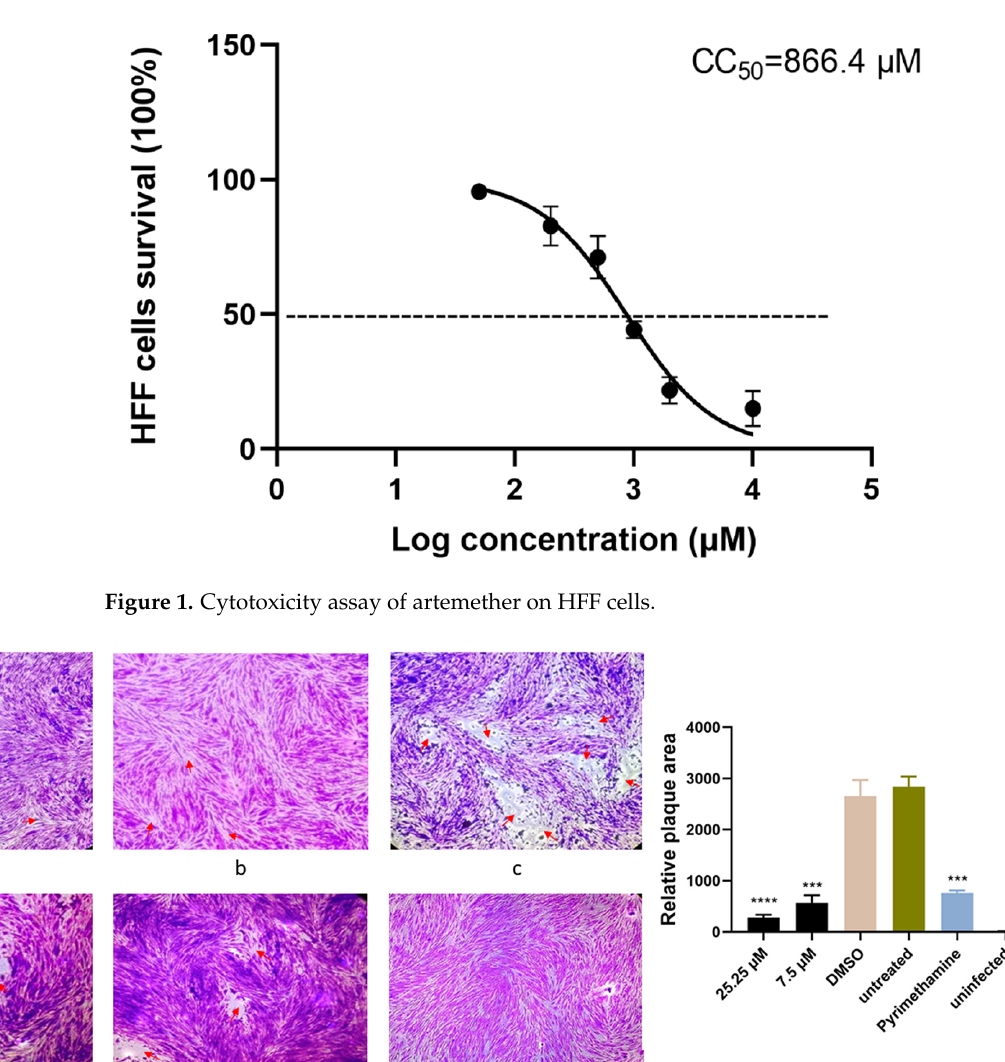
Figure 1. Cytotoxicity assay of artemether on HFF cells.